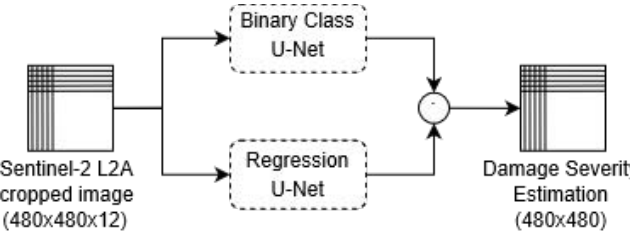
Figure 4. Parallel U-Net simplified architecture. The damage severity estimation is computed by filtering the Regression U-Net output with the burned/unburned binary mask.